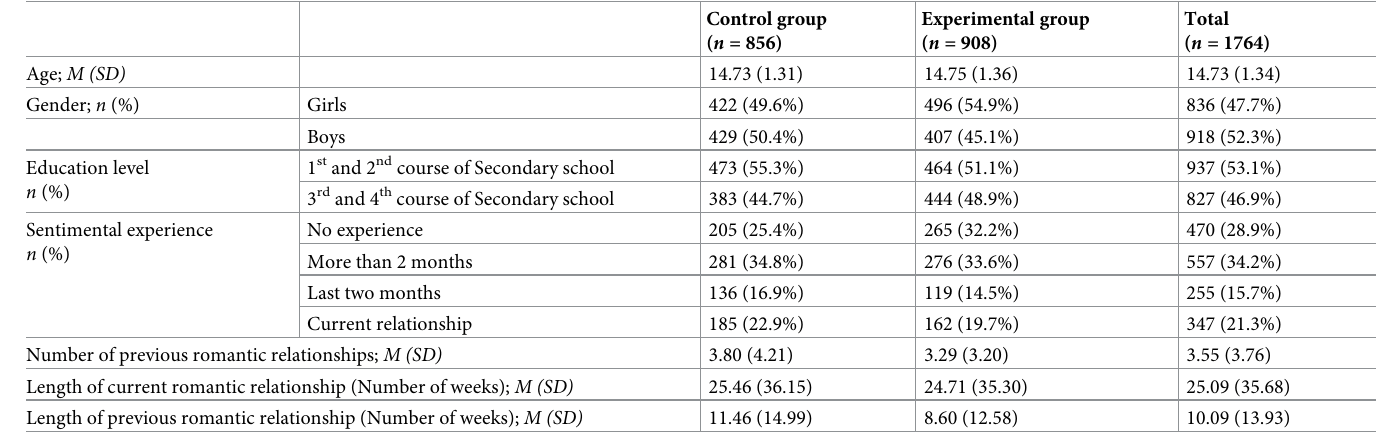
Table 1. Sample descriptive